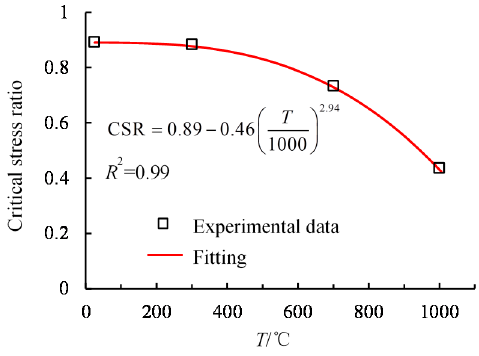
Figure 16. Critical stress ratio versus temperature.